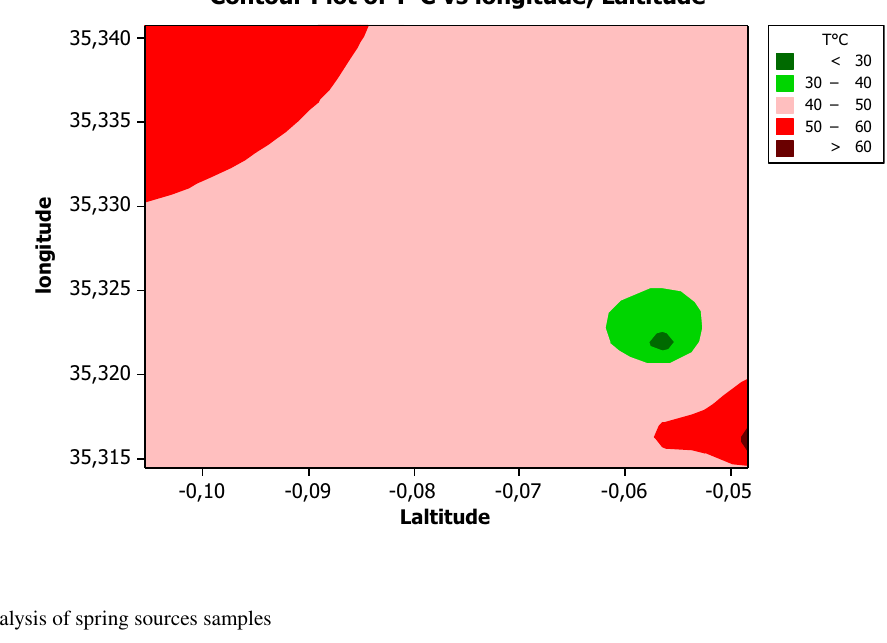
Fig. 8 Spatial variation of